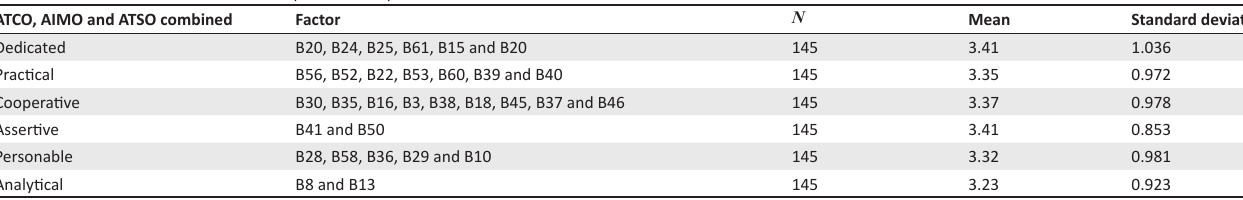
TABLE 3: Leader trait factors and items (noted as ‘B’). ATCO, AIMO and ATSO combined